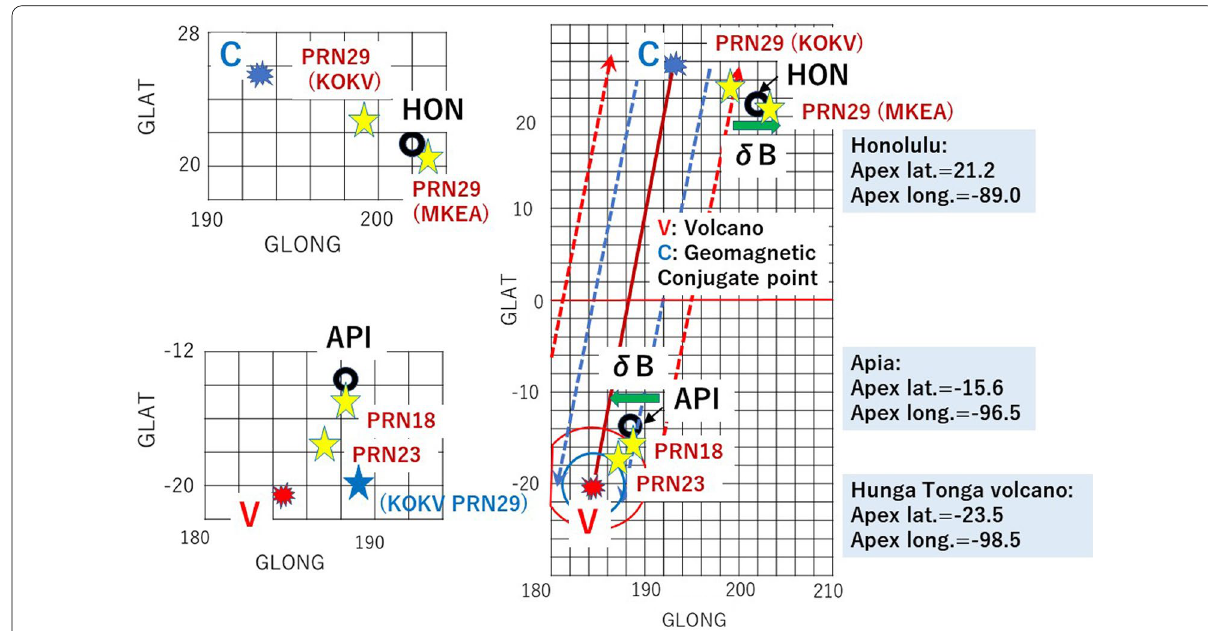
Fig. 3 Location of the volcano (V), its geomagnetic conjugate point (C), Apia and Honolulu geomagnetic observatories (marked by black circles). Dotted red and blue lines with arrow are schematic presentation of oscillating field-aligned currents and thick green arrows present the direction of magnetic field variation at a certain moment. The blue and red circles present expanding atmospheric waves generated by the eruption. The yellow star marks present the location of the line-of-sight intersection, IPP (ionospheric pierce point) at an altitude of 300 km in the ionosphere to GPS PRN29, PRN23 and PRN18 satellites from the receivers at KOKV (22.126 N, 200.335 E), MKEA (19.801 N, 204.544 E) and SAMO (13.849 S, 188.262 E), respectively. Apex latitudes and longitudes of Apia, Honolulu and the volcano are also presented on the right of the figure. Enlarged maps around Samoa and Hawaii are presented on the left. The blue star symbol indicates the location of geomagnetic conjugate point of the IPP between PRN29 and KOKV at 04:30 UT, (19.8 S, 191.0